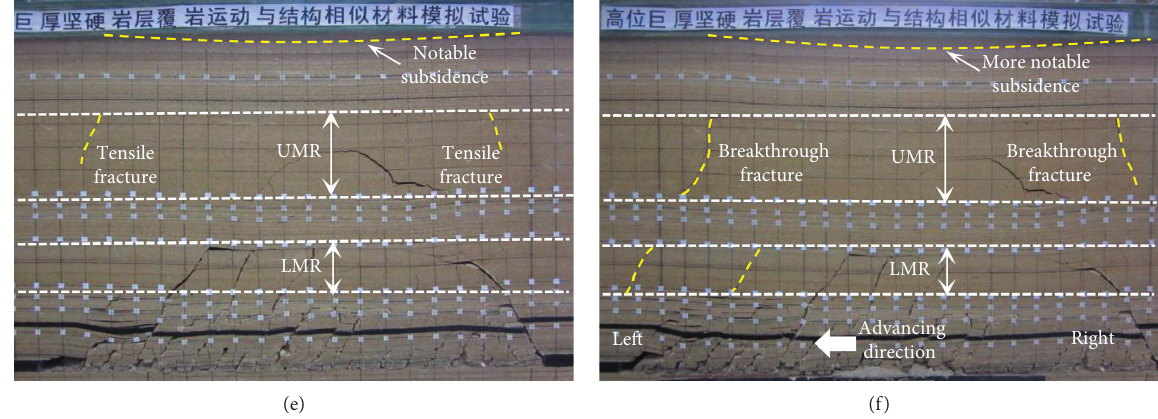
Figure 7: Structural evolution of overburden with several typical mining states. (a) 120 m. (b) 220 m. (c) 236 m. (d) 330 m. (e) 410 m. (f) 470